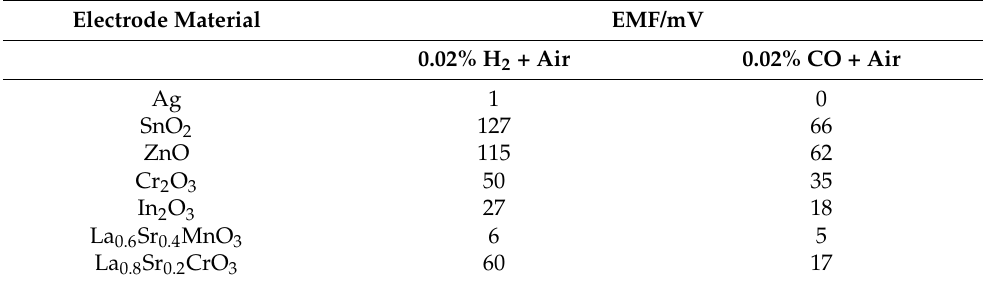
Table 1. EMF response of the different tested solid electrolytes (SEs) at 550 ◦ C. (Data reproduced from